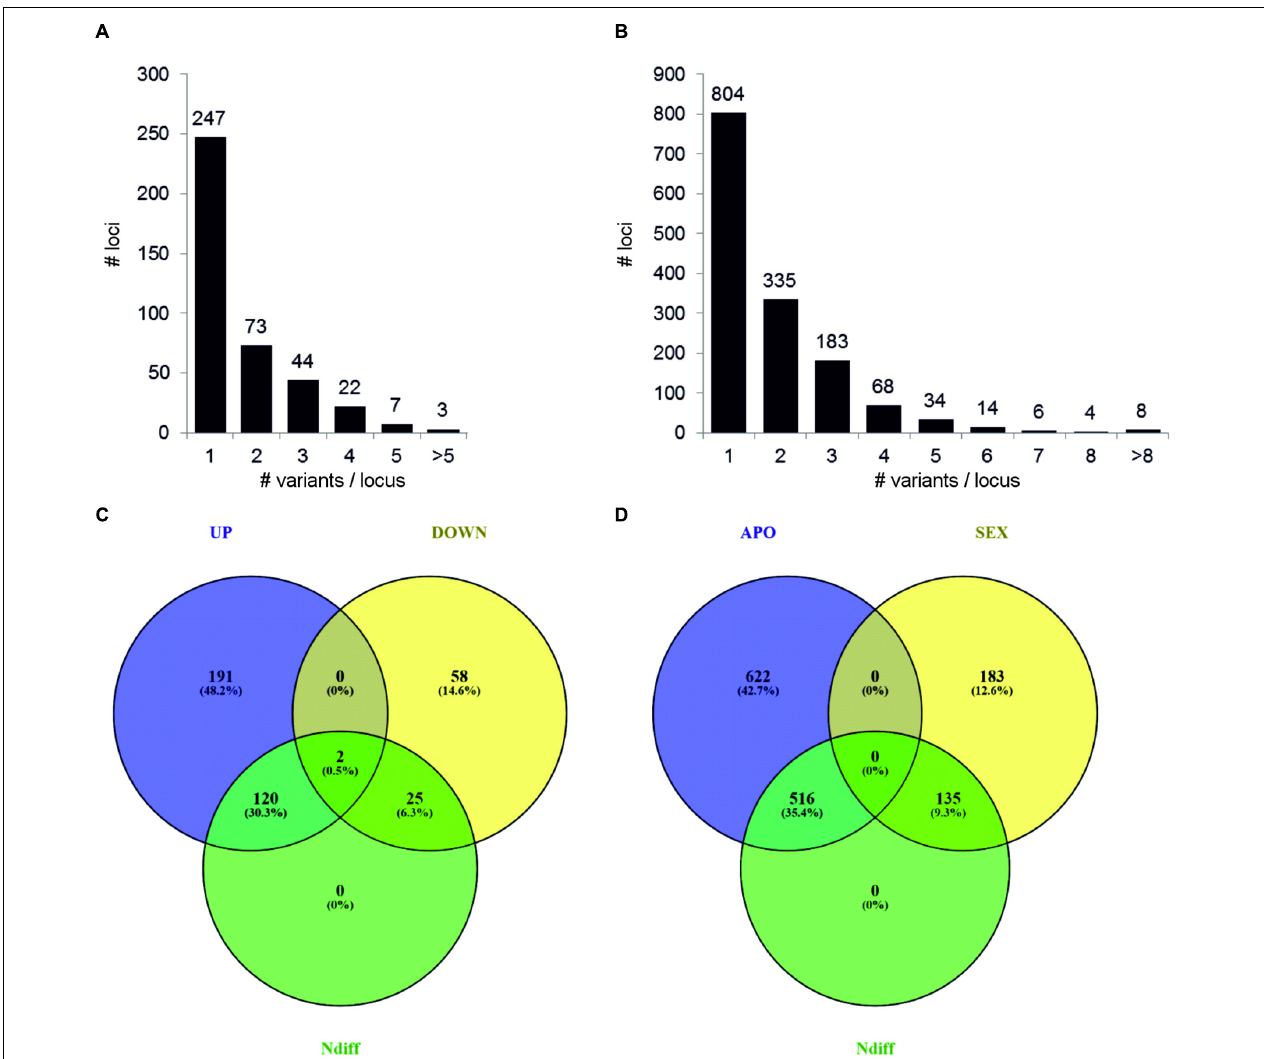
FIGURE 3 | Distribution of single and multiple transcript variants per locus. Metrics are referred to genomic loci containing at least one DEG (A) or phenotype-specific transcript (B) . Transcript variants were defined as transcripts aligning into the same genomic locus. DEGs were defined by considering the Bonferroni p -value correction ( p ≤ 0.05). Phenotype-specific transcripts were defined as transcripts expressed in the three samples of a given phenotype and absent in the three samples of the alternative phenotype. The Venn diagrams show the number of loci associated to transcripts with alternative expression patterns.